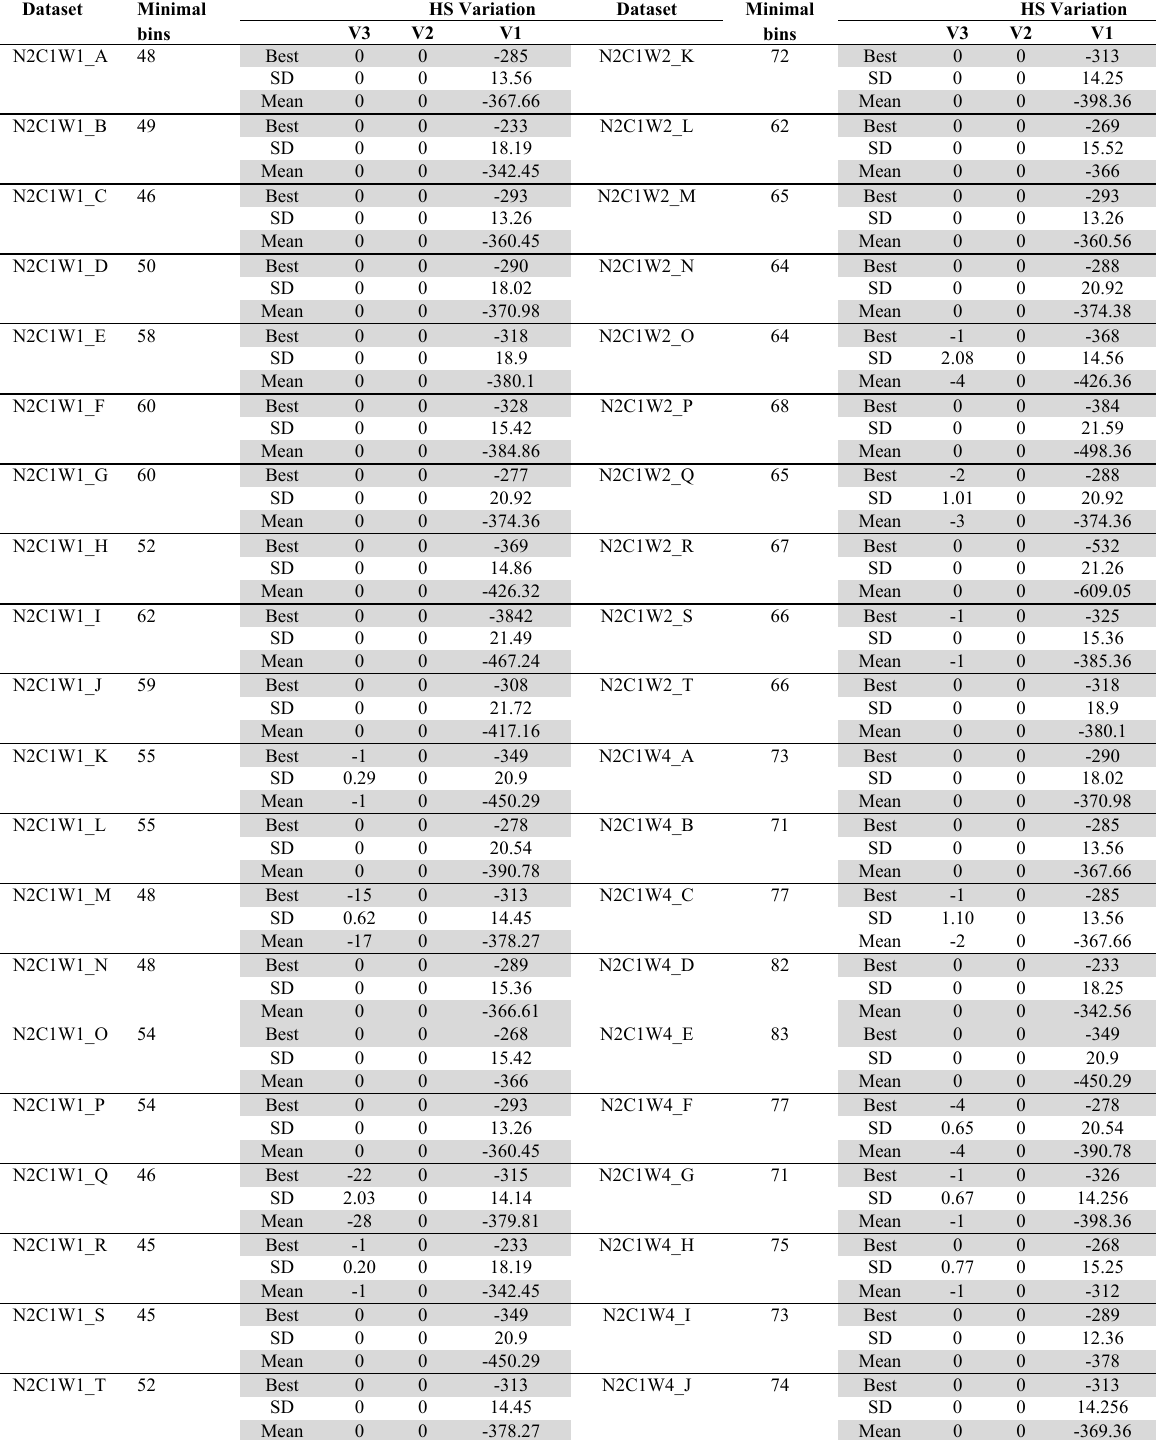
Table 3 and 4 show the obtained best, mean and standard deviation on the objective value of experimented three harmony search algorithm variations for 120 instances of bin packing problem. The basic harmony search algorithm fails to give best known solution for all the instances. The negative values show the penalty applied for constraint violations. Zero value indicates no violation of constraints. HS variations 2 and 3 shows best performance for more than 95% instances of bin packing problem with 100 objects. The performance of variation 2 and 3 are approximately same. Performance of proposed HS variations for 60 datasets with 100 objects